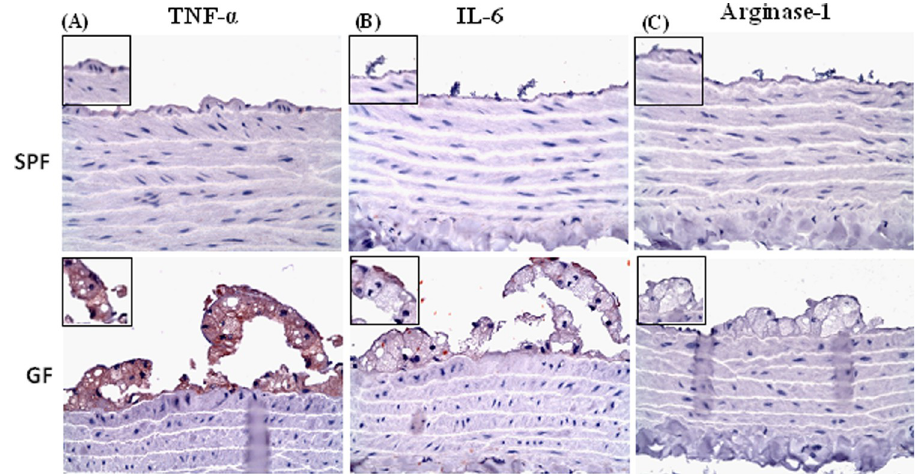
Fig 5. Immunohistochemical staining of thoracic aorta lesions. (A) TNF- α stain. (B) IL-6 stain. (C) Arginase-1 stain. GF: germ free, SPF: specific pathogen free.